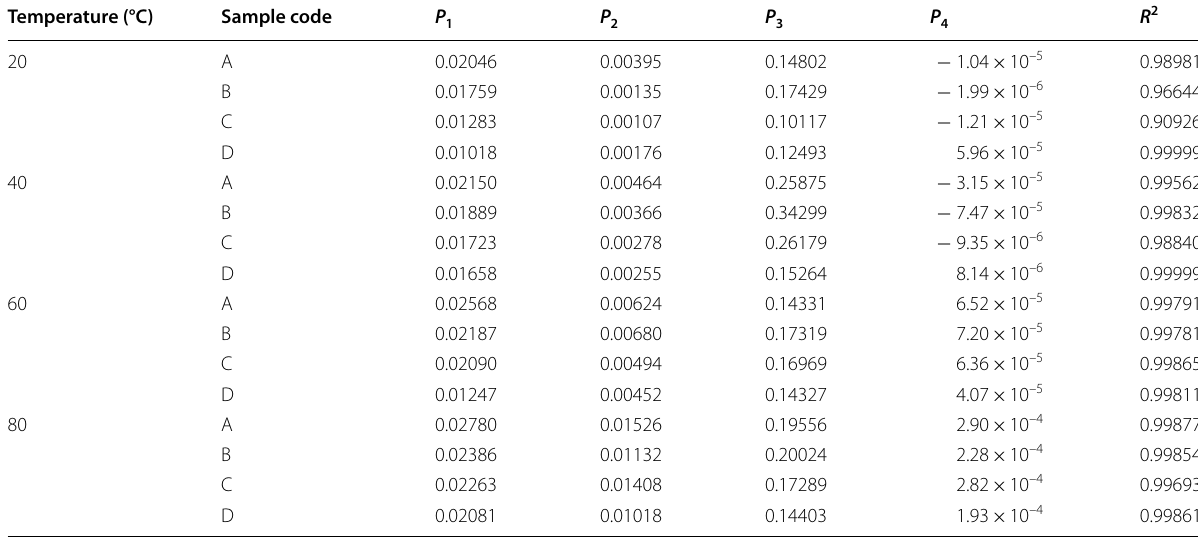
Table 2 Fitting parameters of Burger model for the specimens at different temperatures Temperature (°C)